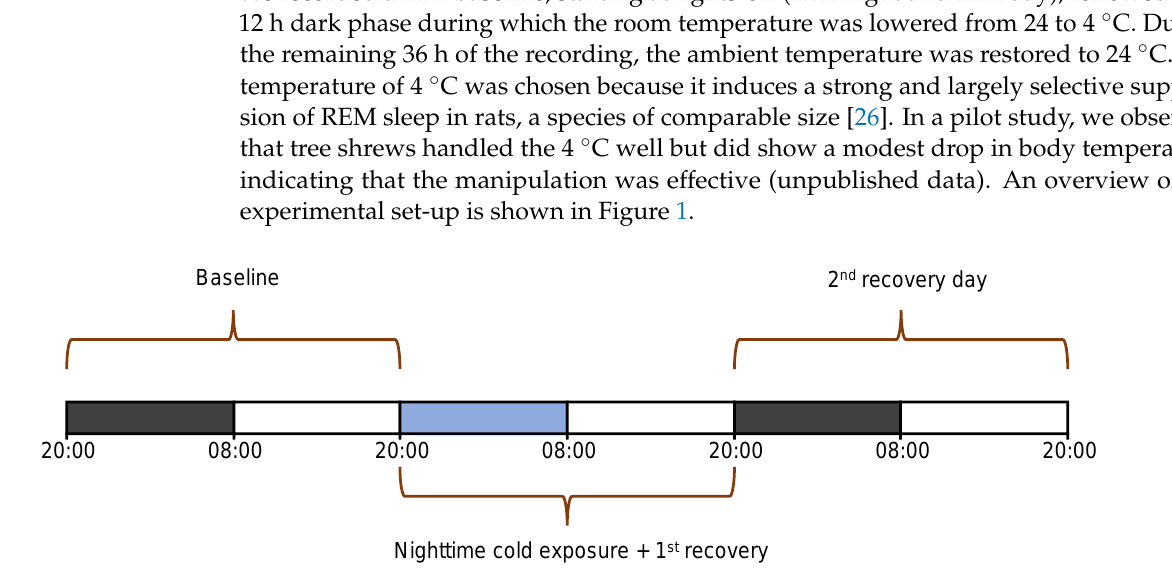
Figure 1. Experimental design consisting of 72 h recordings. The animals were individually housed under 24 °C and a 12:12 h LD cycle, where the black and white bars denote the dark and light phase, respectively. The light-blue bar denotes the night during which the ambient temperature was lowered from 24 to 4 °C. During the remaining 36 h, the ambient temperature was restored to baseline levels (24 °C).